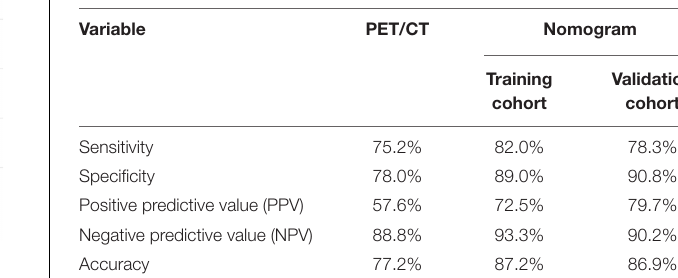
TABLE 3 | Accuracy values of PET/CT and nomogram in LN